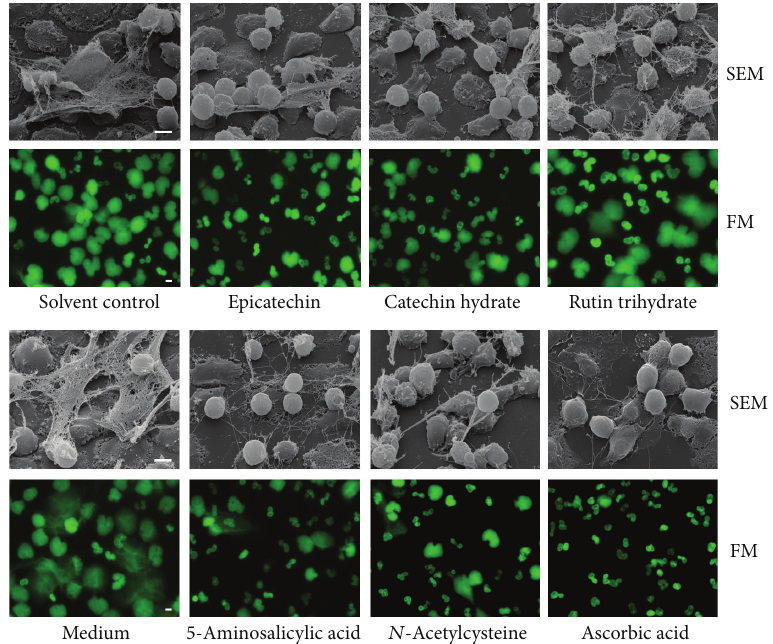
Figure 6: Influence of antioxidants on the formation of NETs as assessed by fluorescence and scanning electron microscopy. Freshly isolated neutrophils were pre-incubated with or without antioxidants (0.5mM 5-aminosalicylic acid, 10 mM N -acetylcysteine, 2mM ascorbic acid, 0.1mM epicatechin, 0.1 mM catechin hydrate, 0.075 mM rutin trihydrate) for 30 min at 37 ∘ C. The DNA was stained with 100 nM SYTOXgreen for detection with fluorescence microscopy (FM). Afterwards, NET formation was induced by stimulation with PMA (20nM scanning electron microscopy (SEM), 10nM FM). The samples were fixed after 4h (SEM) and 3 h (FM). Scale bars represent 5 𝜇 m. Neutrophils stimulated with PMA (Medium) and coincubated with DMSO (solvent control) were used as